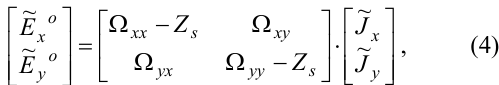
superconducting rectangular microstrip patch in a substrate-superstrate c